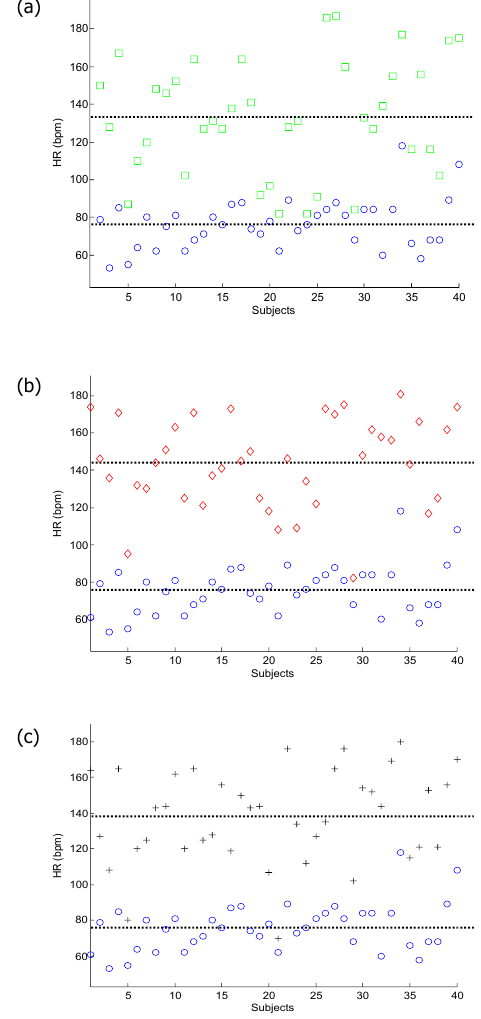
Figure 2. Analysis of the heart rate. ( a ) Heart rate for subjects measured before the simulated heat stress induction (at rest (blue circles)) against those measured after the first simulated heat stress induction (Exercise 1 (green squares)); ( b ) heart rate for subjects measured at rest against those measured after the second simulated heat stress induction (Exercise 2 (red diamond)); ( c ) heart rate for subjects measured at rest against those measured after the third simulated heat stress induction (Exercise 3 (black